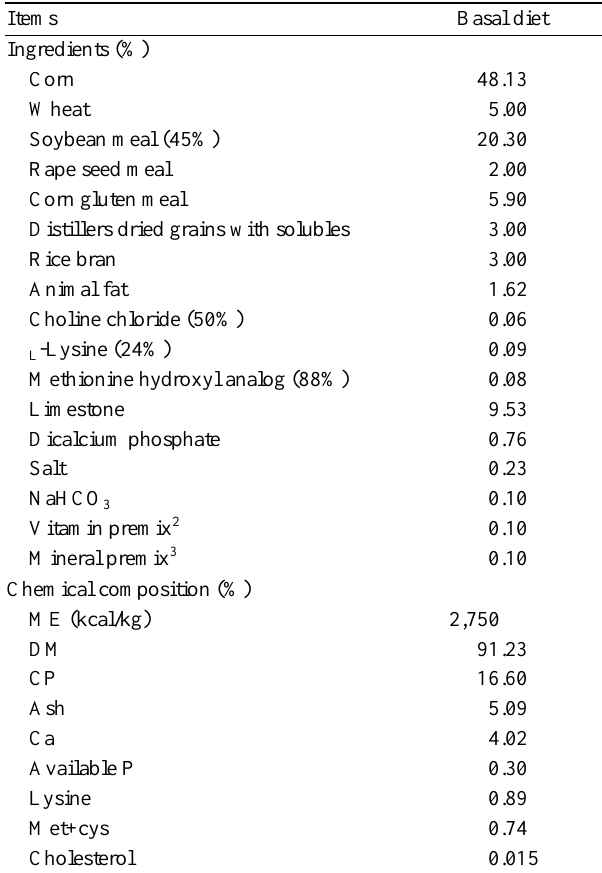
Table 1. Ingredient and chemical composition of basal diet